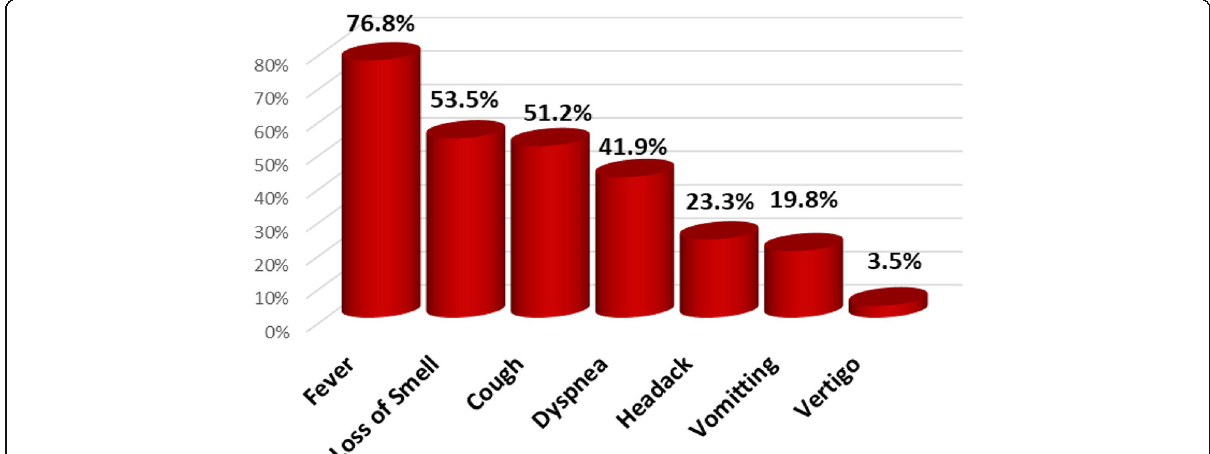
Fig. 3 COVID-19 symptoms frequency among the studied patients